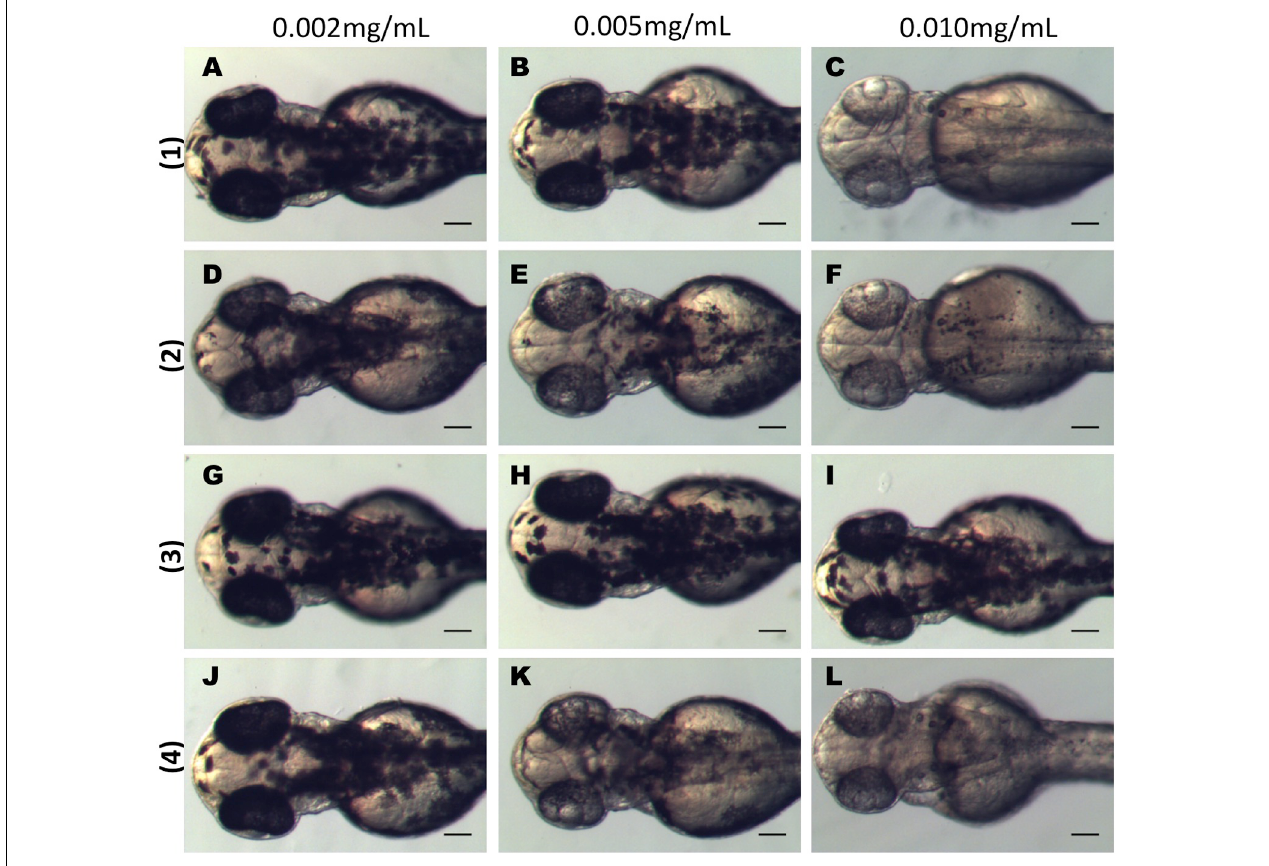
FIGURE 4 | Dibenzofuran compounds inhibit melanogenesis in a dose dependent manner. Synchronized embryos were treated with test compounds at the indicated concentrations from 24 hpf for 24 h. The effects on the pigmentation of zebrafish were observed at 48 hpf under the stereomicroscope. Treatment with 0.002 mg/mL had no effect on pigmentation for any of the tested compounds (A,D,G,J) . Mild effect on melanogenesis was observed at 0.005 mg/mL (B,E,K) . At 0.01 mg/mL there was a strong inhibition of melanogenesis (C,F,L) . Compound 3 had no effect at any of the tested concentrations (G–I) . Scale bar: 100 µ M.